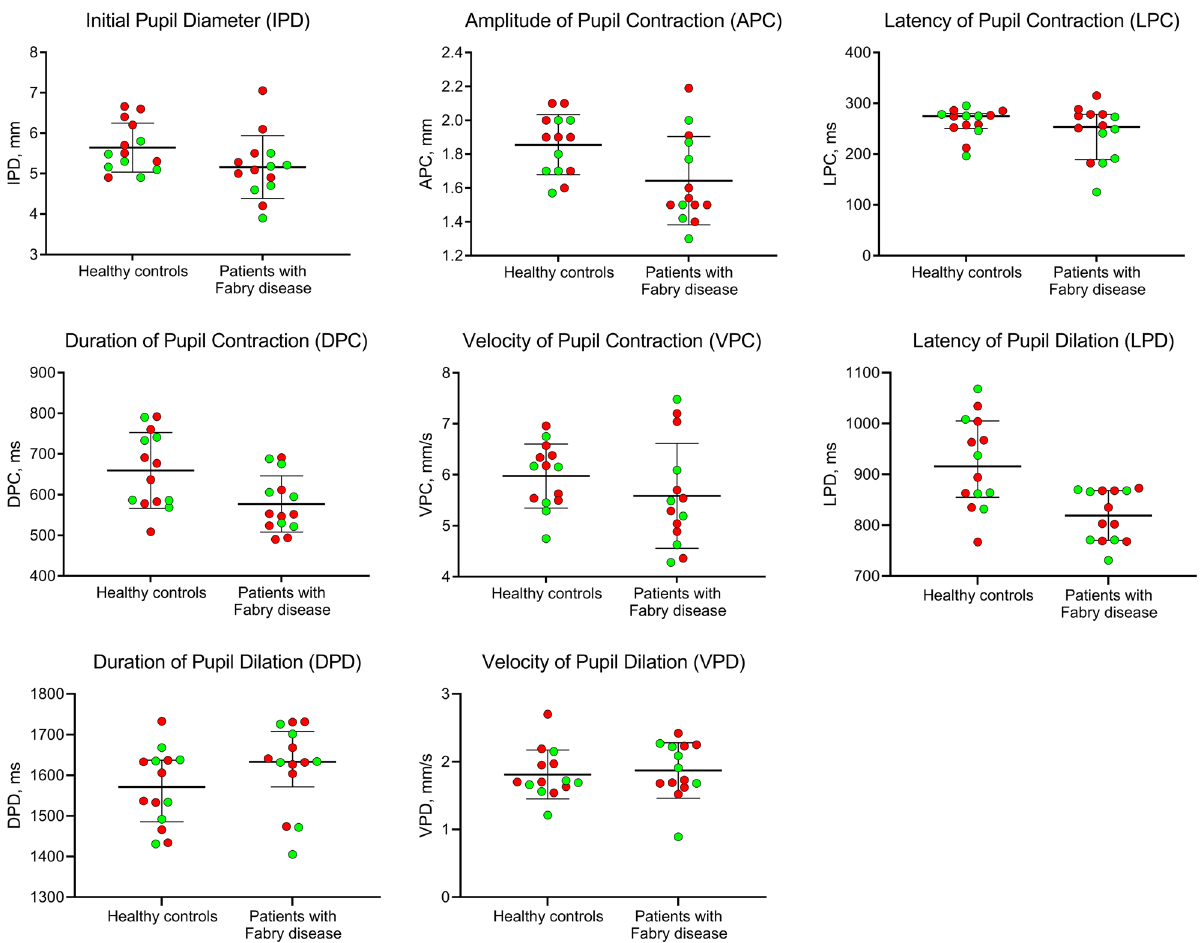
Figure 1. Dynamic pupillometry parameters in healthy control subjects and patients with Fabry disease, showing a significant reduction in APC ( P = 0.048), DPC ( P = 0.048) and LPD ( P = 0.048), and no change in IPD ( P = 0.154), LPC ( P = 0.326), VPC ( P = 0.326), DPD ( P = 0.326), and VPD ( P = 0.688) in Fabry patients. Red and green dots represent male and female participants,